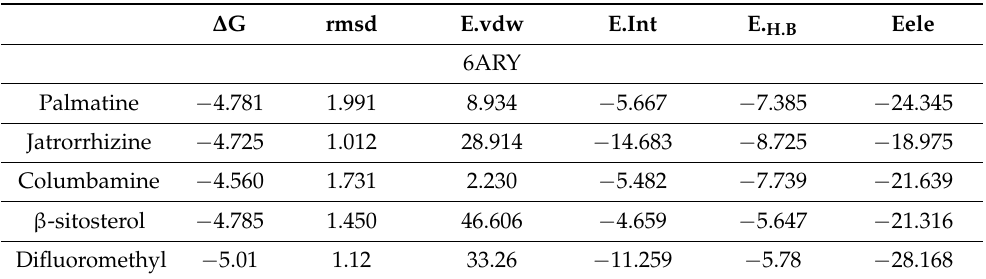
Figure 7. Docked in the active sites of AChE and GST, with corresponding 2D maps. H-Bond is characterized by blue lines, hydrophobic interactions are presented by green dotted lines. Table 4. The docking energy scores (kcal/mol) for the isolated component reference inhibitor.